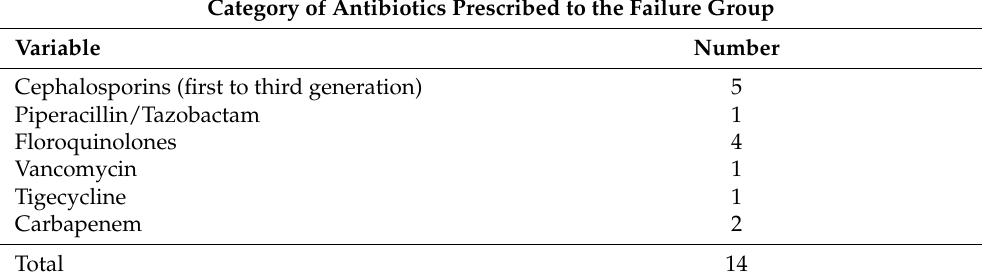
Table 5. Antibiotics list of systemic antibiotic